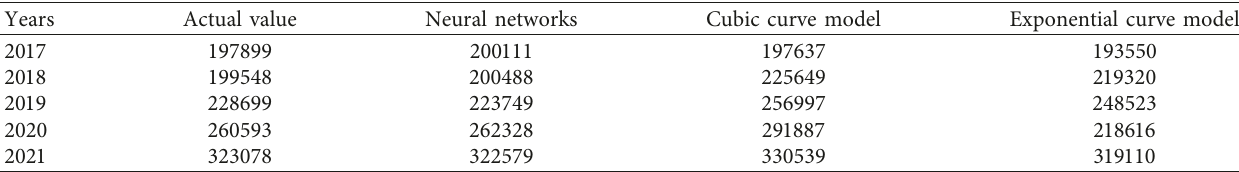
Table 5: Comparison of simulation results of different models.